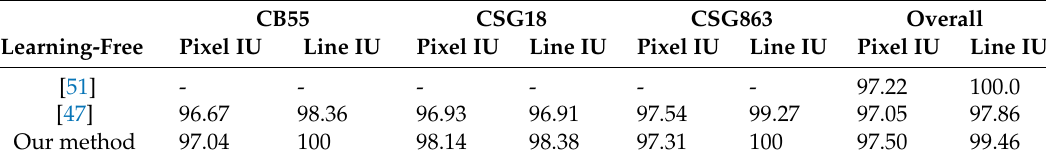
Table 5. Comparison of our method with state-of-the-art results on DIVA-HisDB dataset.